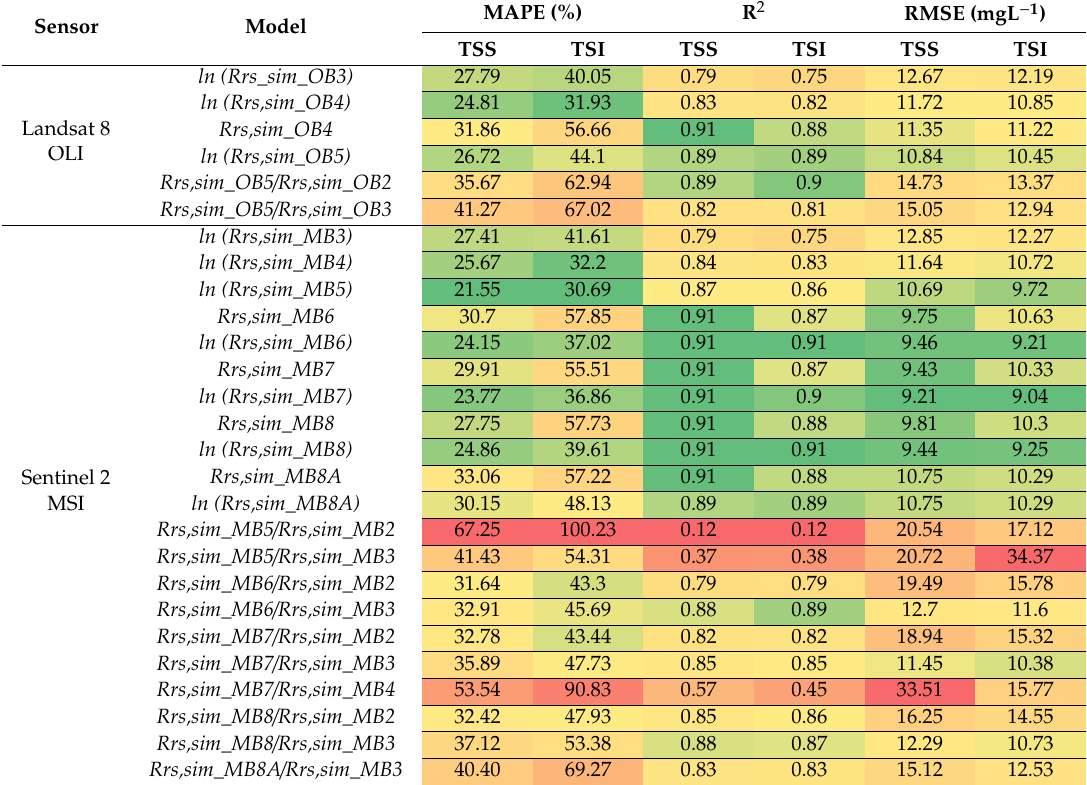
Table3. ThevalidationresultsobtainedthroughaMonteCarlosimulationforthelinear, log-transformed, and band-ratio models for both OLI and MSI sensors: The table colors refer to the model performance and becomes better towards a greener hue and worse towards red. Number of validation samples: